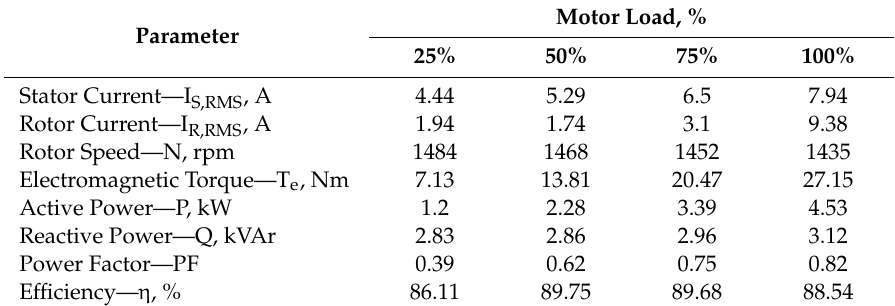
Table 2. The characteristic sizes of the IM in the symmetrical and sinusoidal regime, for di ff erent loads. Motor Load, % Parameter 25% 50% 75%